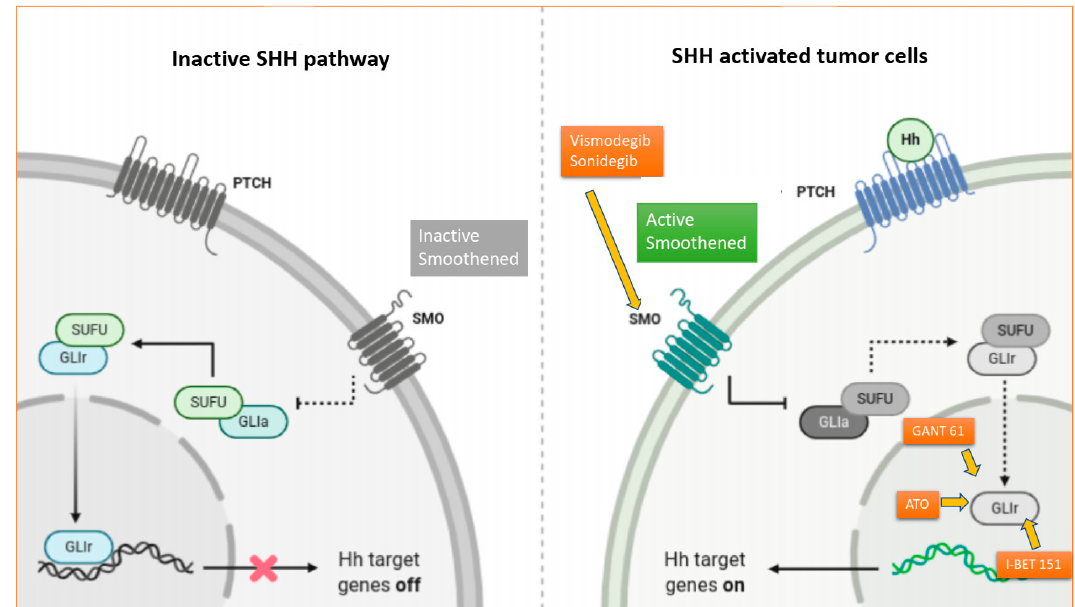
Figure 1. The complex Hedgehog signaling cascade and mechanism of action of SMO and GLI inhibitors. In the absence of HH proteins, PTCH 1 inhibits Smoothed (SMO) and acts as a negative regulator of the HH signaling pathway. Conversely, when HH proteins are present, they bind to PTCH1, hindering its inhibition of SMO. Activated SMO upregulates the SMO-SUFU-GLI signaling cascade, which promotes the transcription of the GLI (glioma-associated oncogenes), leading to tumor proliferation, invasion, tumor metastasis and cancer stem cell survival. Vismodegib and sonidegib are two small oral molecules that are selective antagonists of the HH pathway, which act by directly binding to SMO, inhibiting downstream activation of the HH-signaling cascade. GANT-61 is a GLI-inhibitor that has shown potent inhibition of GLI1 and GLI2 in preclinical studies of MB cancer cell lines. Arsenic trioxide (ATO) antagonizes the canonical SHH pathway by directly binding to GLI1 and has shown anticancer activity against MB both in in vitro and in vivo preclinical studies. I-BET 151, an inhibitor of the bromodomain protein BRD4, has also been shown to directly interact with GLI1 and GLI2, reducing the GLI-transcriptional activity.